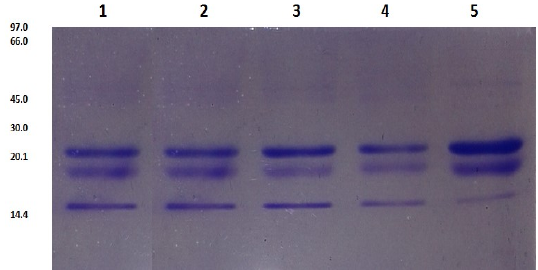
Figure 1. SDS-PAGE electrophoresis of caseins proteins with 2-mercaptoethanol. Lane 1: milk 1; lane 2: Figure 1. SDS ‐ PAGE electrophoresis of caseins proteins with 2 ‐ mercaptoethanol. Lane 1: milk 1; lane 2: milk 2; lane 3: milk 3; lane 4: milk 4 and lane 5: whole cow milk.